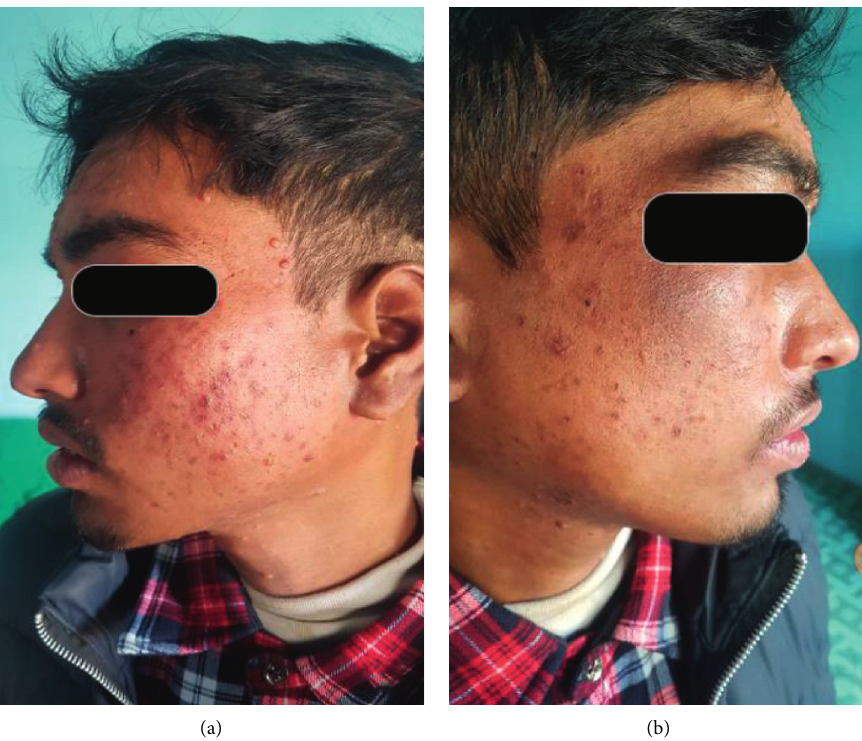
Figure 2: (a, b) Resolution of MC after one month of therapy with oral